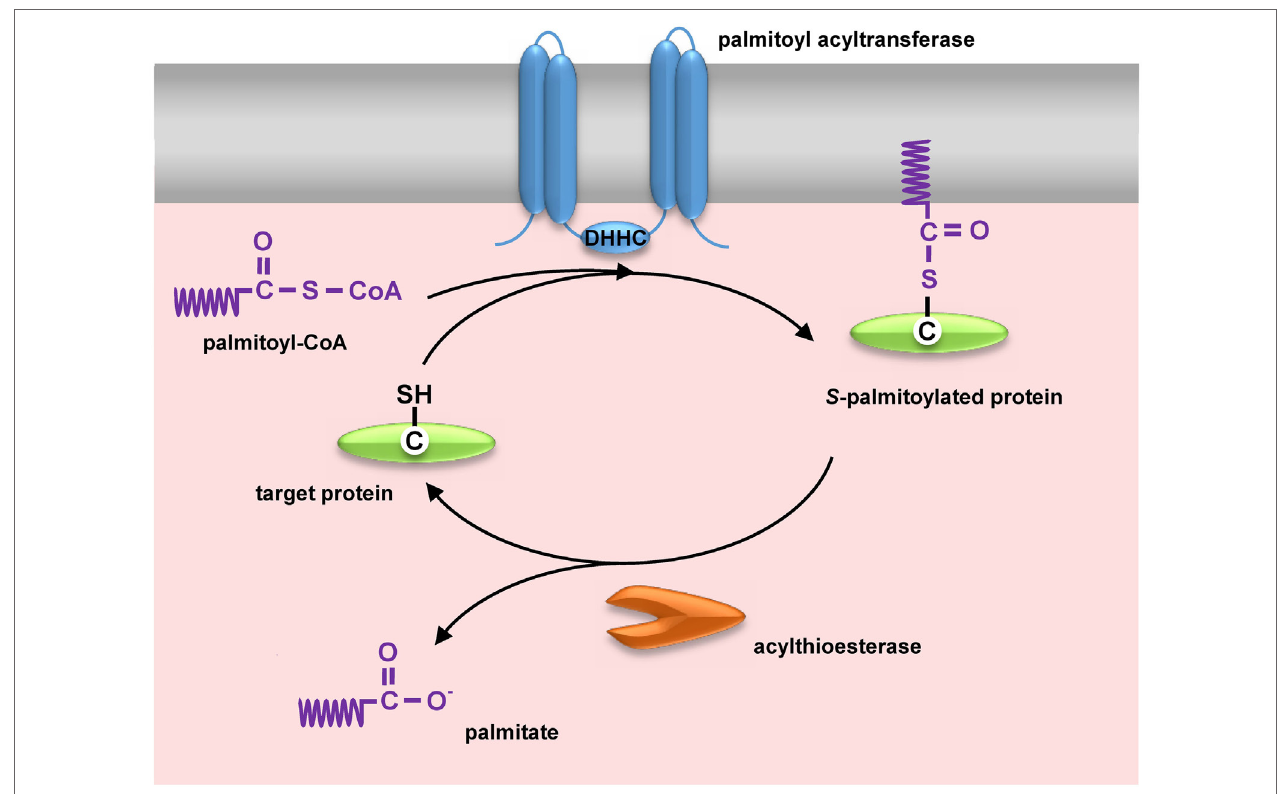
FigURe 1 | Dynamic protein S -palmitoylation. Palmitate is transferred to the thiol group of cysteine from palmitoyl-CoA by integral membrane zDHHC-family palmitoyl acyltransferases. Upon S -palmitoylation cytosolic proteins gain a hydrophobic moiety allowing their anchoring in the membrane. Proteins are depalmitoylated by acylthioesterases [acyl-protein thioesterase (APT) 1/APT2 and ABHD17] and translocate to the